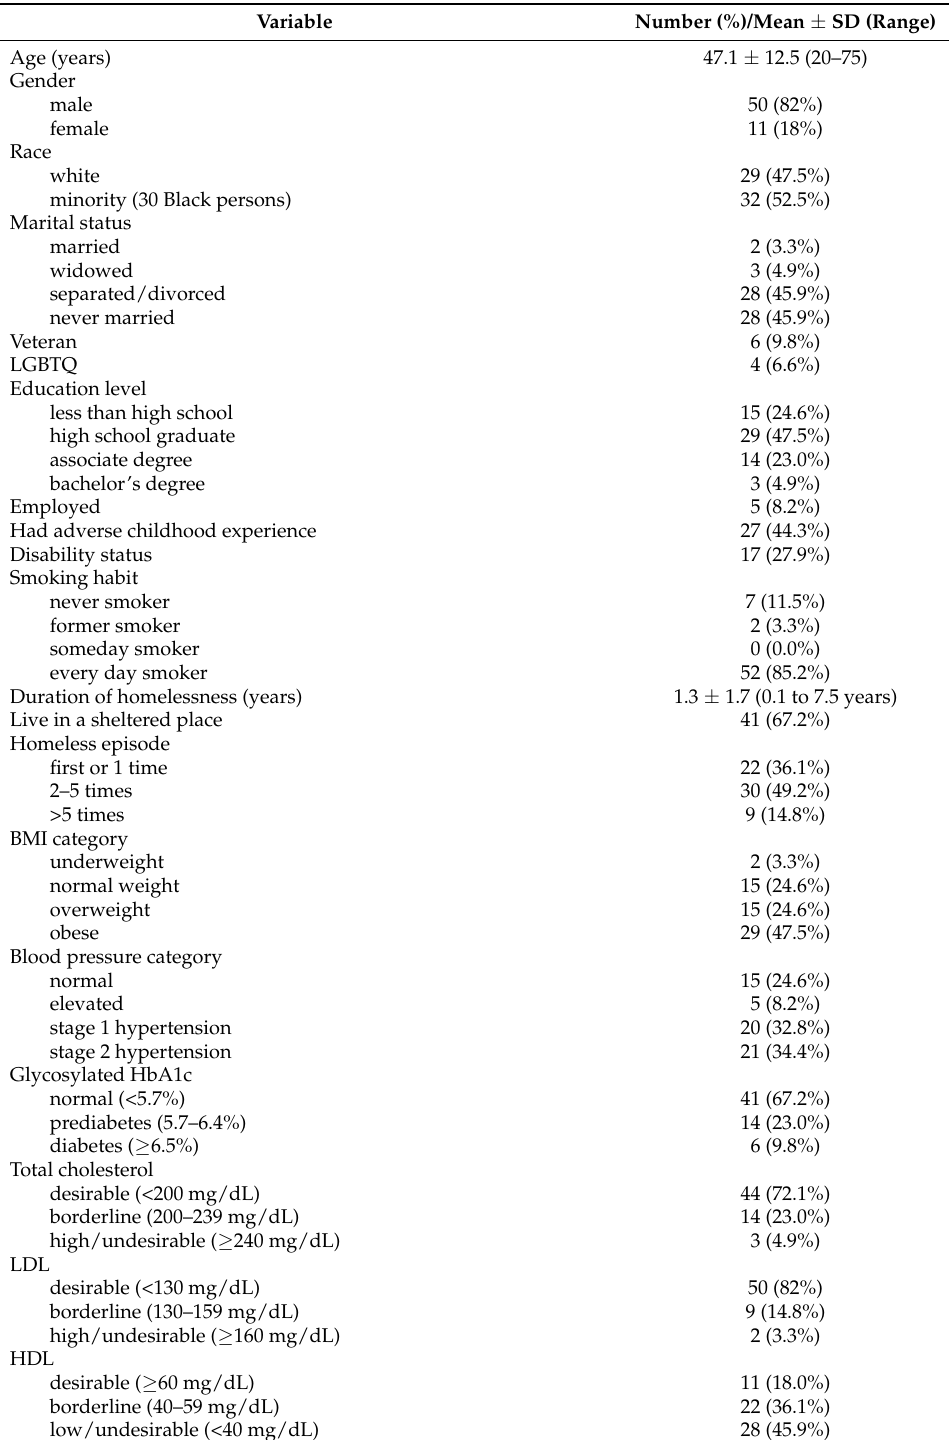
Table 1. Characteristics of homeless participants ( n =